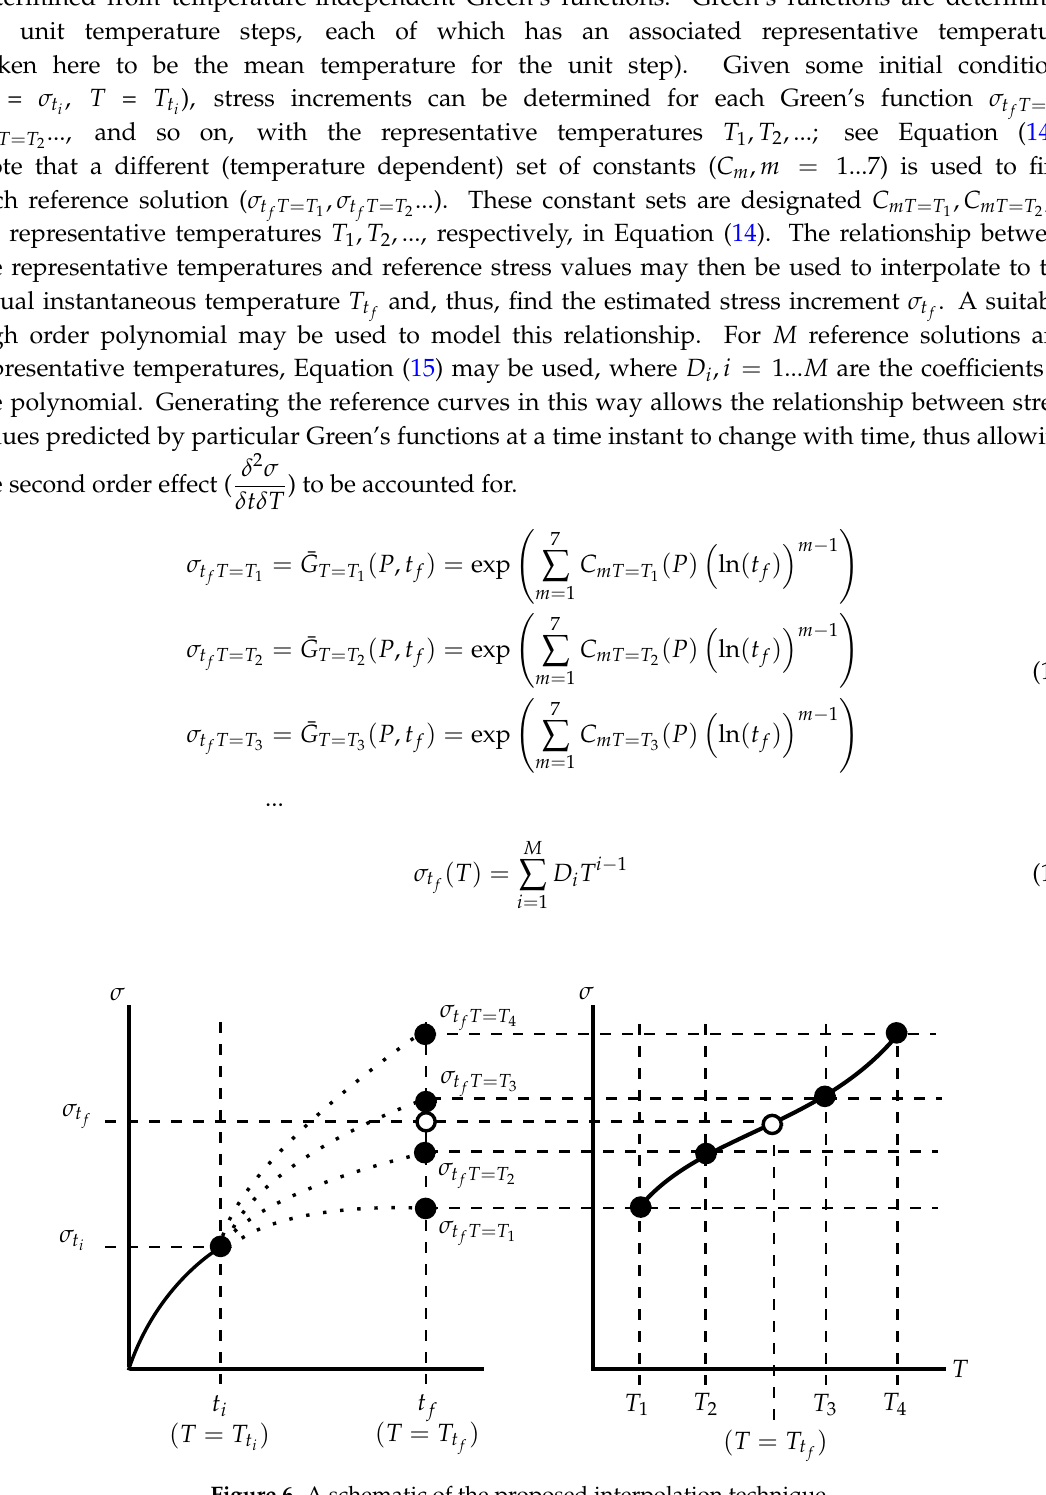
Figure 6. A schematic of the proposed interpolation